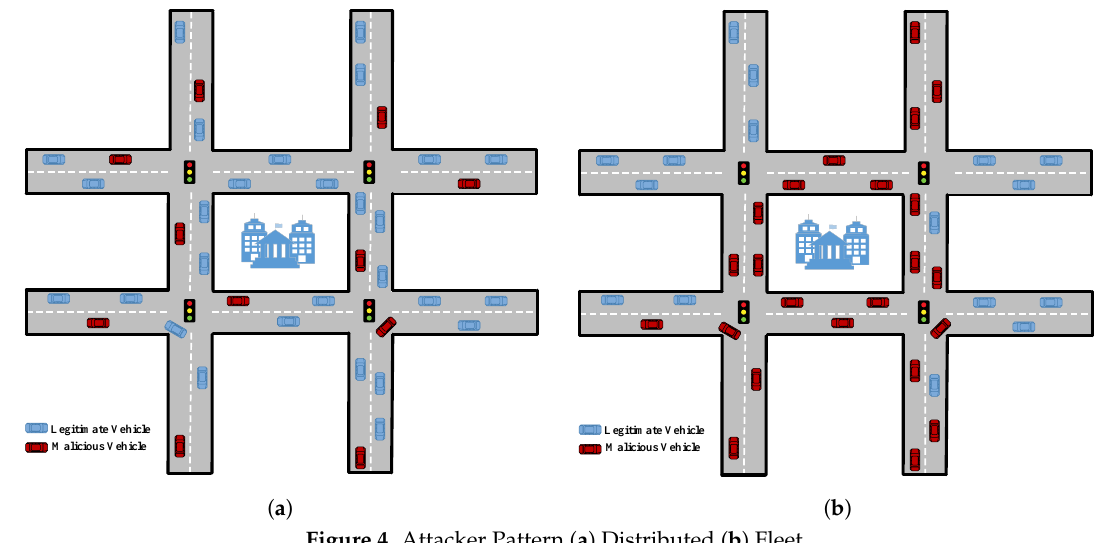
Figure 4. Attacker Pattern ( a ) Distributed ( b )